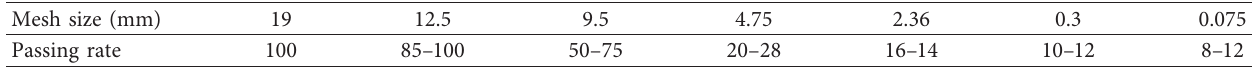
Table 4: SMA-13 asphalt concrete gradation.